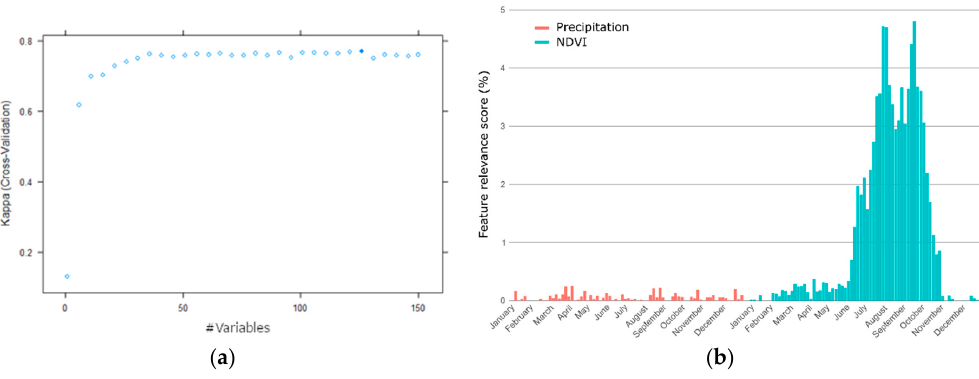
Figure 13. Classification model generated using Boosted DT as classifier and by applying a recursive feature selection process (scenario 3), which maximized the accuracies on the validation set as shown in Table 8. (a) The plot reports the Kappa statistic obtained in cross-validation in function of the number of variables/features used to build the model. A number of features equal to 126 maximized the Kappa statistic, which is highlighted with the filled circle. (b) The feature relevance score. Overall, larger weights were given to NDVI features (mainly in the June–October time frame) rather than satellite precipitation data.